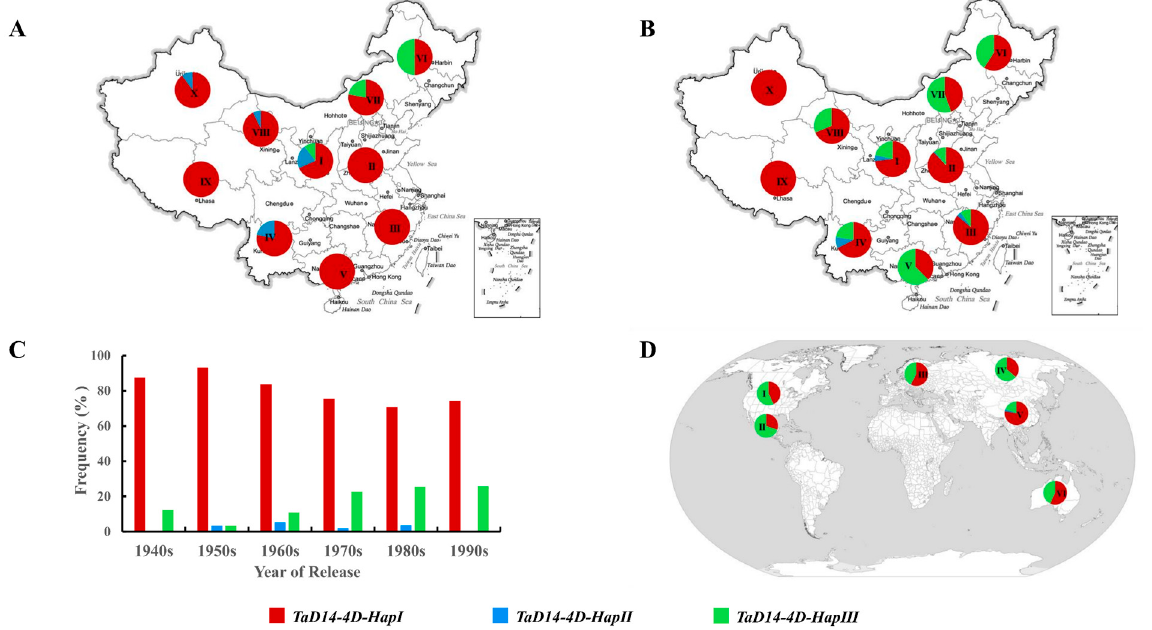
Figure 8. Spatial and temporal distribution of TaD14-4D haplotypes. ( A , B ) Distribution of TaD14-4D haplotypes in ten Chinese ecological regions (I, northern winter wheat region; II, Yellow and Huai River valley winter wheat region; III, low and middle Yangtze River valley winter wheat region; IV, southwestern winter wheat region; V, southern winter wheat region; VI, northeastern spring wheat region; VII, northern spring wheat region; VIII, northwestern spring wheat region; IX, Qinghai–Tibet spring–winter wheat region; X, Xinjiang winter–spring wheat region). ( A ) Representation of 157 landraces from ten Chinese ecological regions. ( B ) Representation of 348 modern cultivars from ten Chinese ecological regions. ( C ) The changes in the frequency of TaD14-4D haplotypes in Chinese wheat breeding history (from the 1940s to the 2000s). ( D ) Distribution of TaD14-4D haplotypes in major global wheat ecological regions (I, North America; II, CIMMYT; III, Europe; IV, former USSR; V, China; VI, Australia).